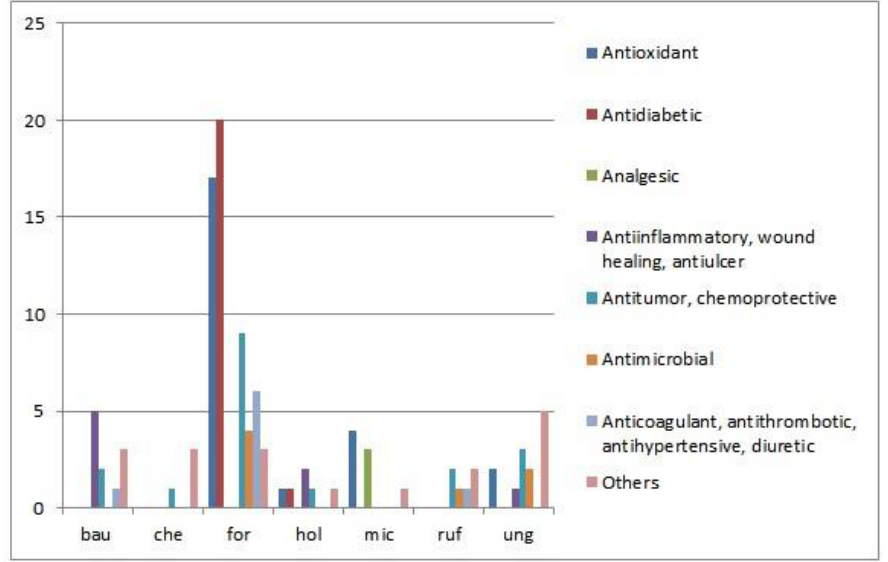
Figure 2. Biological activity of austral South American Bauhinia . Graphical representation of the number of published studies that reported each biological activity. The activities are grouped into eight categories discussed in Sections 3.1–3.8 in the text. bau —bauhinioides ; che— cheilantha ; for—